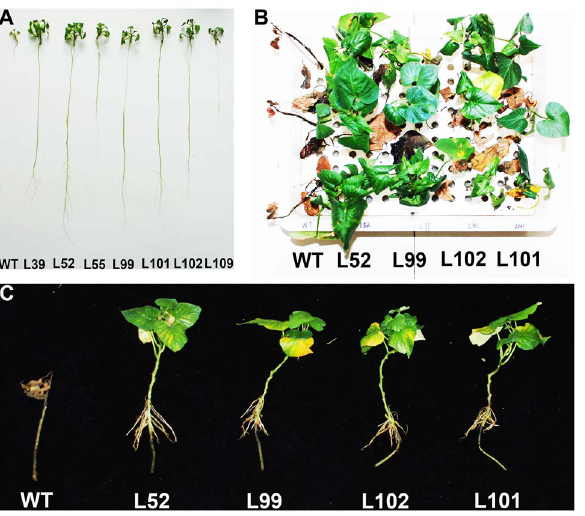
Fig. 5. Responses of the IbMas -overexpressing sweetpotato plants under 86 mM NaCl stress. (A) The growth and rooting of trangenic plants and wild-type plant (WT) cultured for 4 weeks on MS medium supplemented with 86 mM NaCl. (B) and (C) Phenotypes of salt-tolerant transgenic plants (L52, L99, L102 and L101) and WT incubated for 4 weeks in Hoagland solution with 86 mM NaCl; all of the cuttings of L52, L99, L102 and L101 formed obvious new leaves and roots and those of WT died.